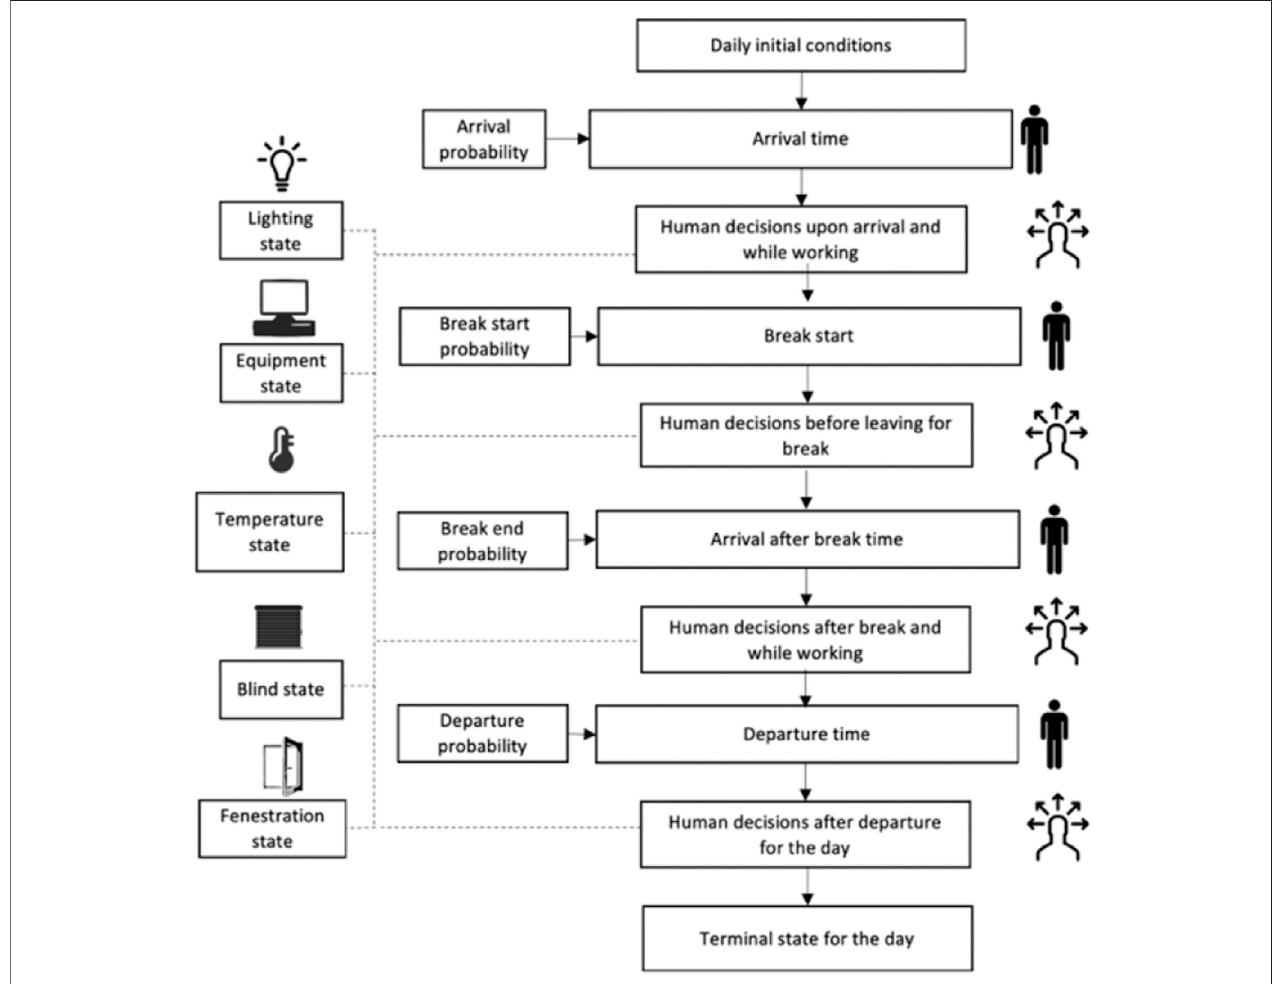
FIGURE 4 | Stochastic input modeling for the building simulation.